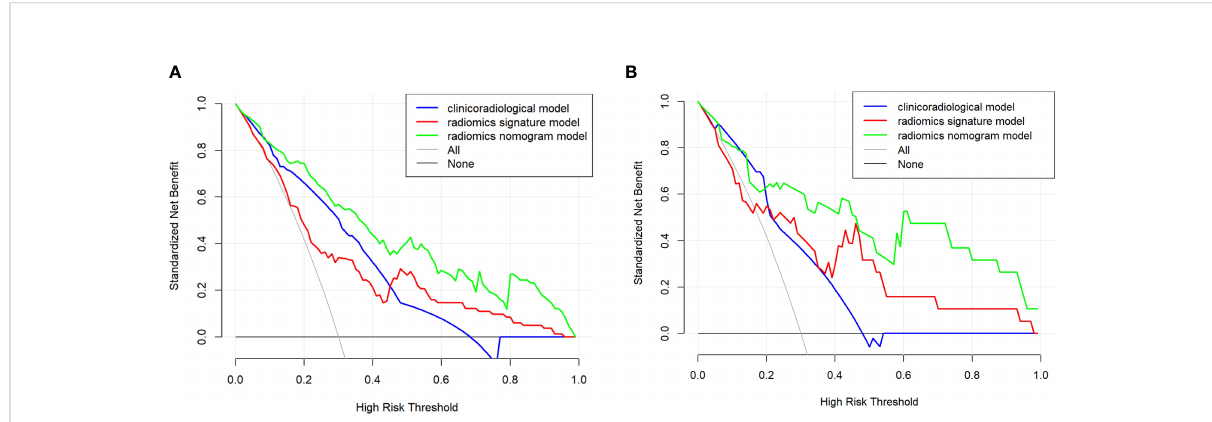
FIGURE 5 The clinical utility of the nomogram was evaluated by decision curves in the training and validation cohort (A, B) , respectively. In the decision curves, the black line indicates the net bene fi t of assuming that there are no patients with microvascular invasion (MVI), and the grey line indicates the net bene fi t of assuming all patients with MVI. The radiomics nomogram model (green line) provided a greater net bene fi t than the clinicoradiological model (blue line) and radiomics signature model (red line).